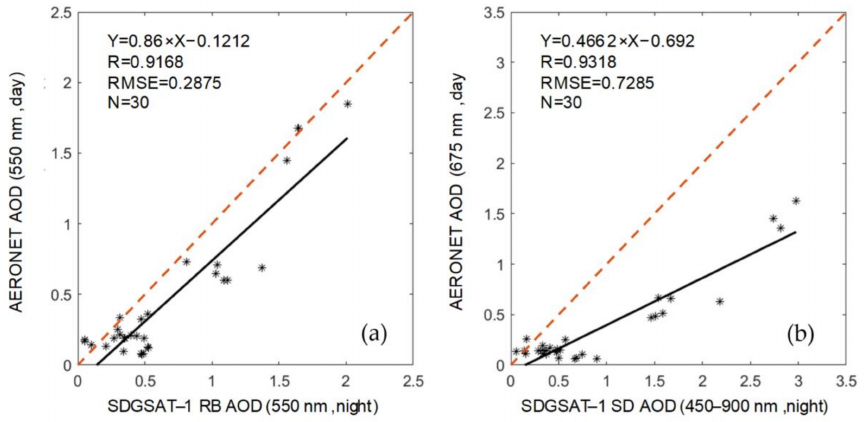
Figure 8. Comparison of AOD values obtained by SDGSAT-1/GLI data and daytime AERONET stations using RB ( a ) and SD algorithm ( b ),